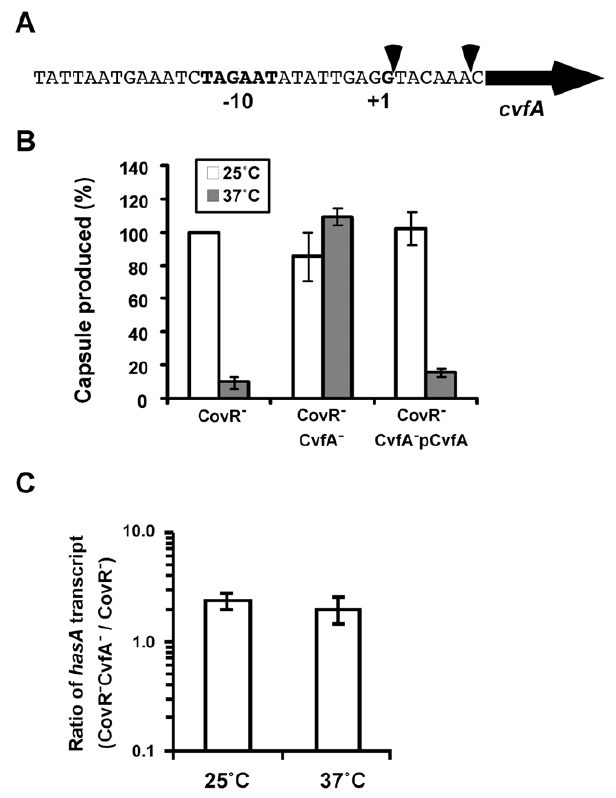
Figure 3. CvfA is required for the thermoregulation of capsule production. A) Transposon insertion sites in the transposon-generated CvfA 2 mutants. The nucleotide sequence in front of the start codon of cvfA is shown. The horizontal arrow represents 5 9 - side of the cvfA gene. The putative 2 10 promoter element and transcription start site ( + 1) are indicated in bold. Each transposon insertion site in the transposon- generated CvfA 2 strains was shown with a vertical arrowhead: transposon insertion between G and T in the CovRIFD:TnCvfA1 strain and between A and C in the CovRIFD:TnCvfA2 strain. These transposon insertions eliminated thermoregulation of capsule production. B) The transposon-generated CvfA 2 mutant regained the phenotype of capsule thermoregulation upon cis -complementation. The transposon insertions that prevent the expression of cvfA abolished the capsule thermoregulation of the CovR 2 background strain; the transposon- generated CvfA 2 strain overproduced capsule regardless of the incubation temperatures. The introduction of an intact copy of cvfA into the chromosome of the transposon-generated CvfA 2 strain ( cis - complementation) restored capsule thermoregulation. C) The transpo- son-generated CvfA 2 mutation did not influence the capsule gene transcription even at 25 u C. The transposon-generated CvfA mutant was grown on THY agar plates at 37 u C overnight ( , 18 hrs) and the fully- grown colonies were incubated for another six to eight hrs at each temperature (25 u C or 37 u C). The quantity of the capsule transcript in the strain was then measured with real time-RT (reverse transcriptase) PCR and compared to that in the CovR 2 background strain. The following strains were used: CovR 2 strain (CovR 2 ), CovRIFD; CvfA 2 CovR 2 strain (CovR 2 CvfA 2 ), CovRIFD:TnCvfA1; CvfA complemented strain of Cov- RIFD:TnCvfA1 (CovR 2 CvfA 2 pCvfA),